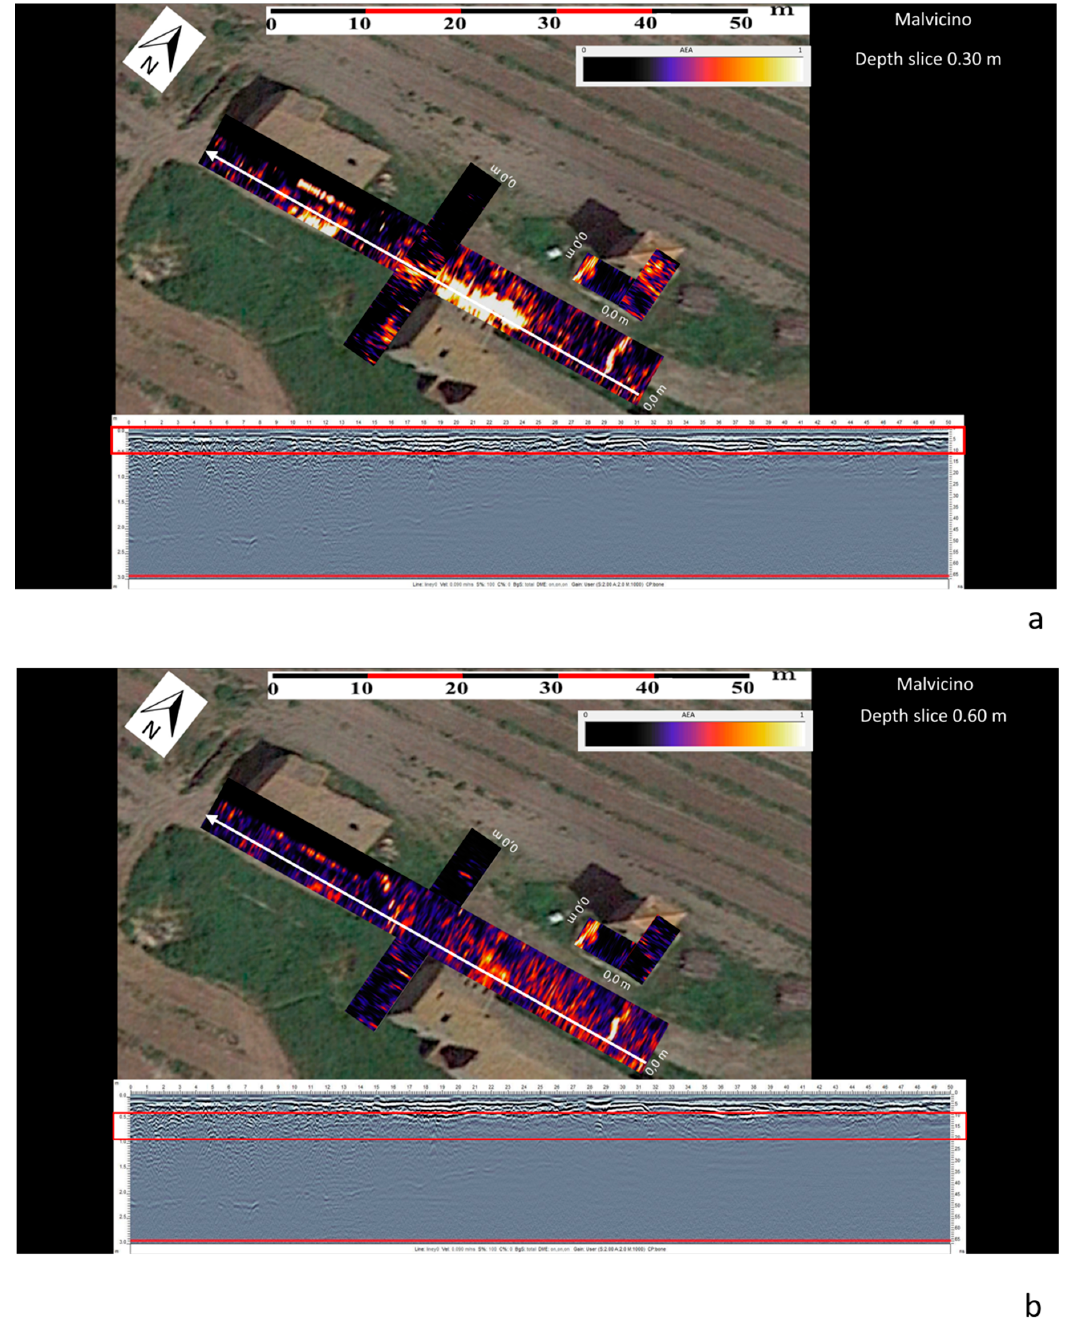
Figure 10. ( a ) The GPR map at a depth of 0.3 m. ( b ) The GPR map at a depth of 0.6 m. The anomalies potentially related to the modern structures are visible. Below are the radargrams collected along the white arrows, with red rectangles due to the relative depth of the